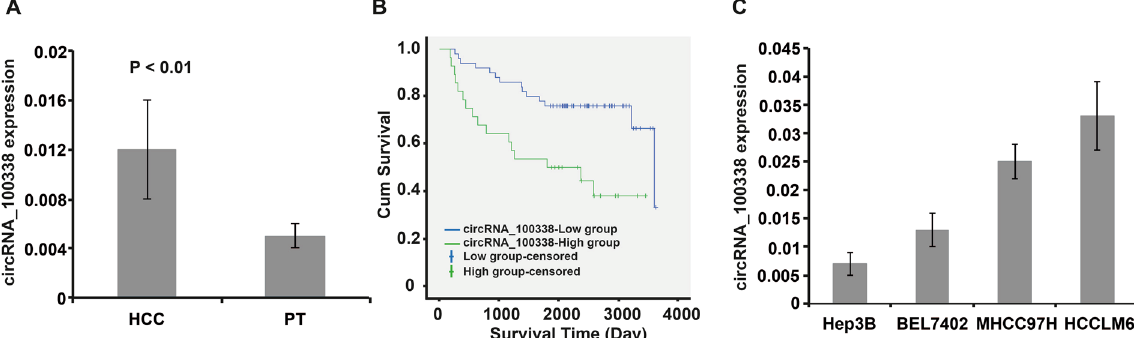
Figure 3. Expression level of circRNA_100338 is correlated with patient cumulative survival rate and HCC metastasis. ( A ) qRT-PCR verification of circRNA_100338 expression in HCC tissues and paired pericancerous tissues (PT) samples (total of 80 patient samples; n = 80). ( B ) Longer survival in the circRNA_100338-low group (low group) compared with the circRNA_100338-high group (high group) was observed; P < 0.01. In this study, “censored” refers to survival cases at the end of follow-up. ( C ) HCC cell lines with higher metastatic potential expressed a higher level of circRNA_100338. Statistical testing was performed with one way ANOVA; P <